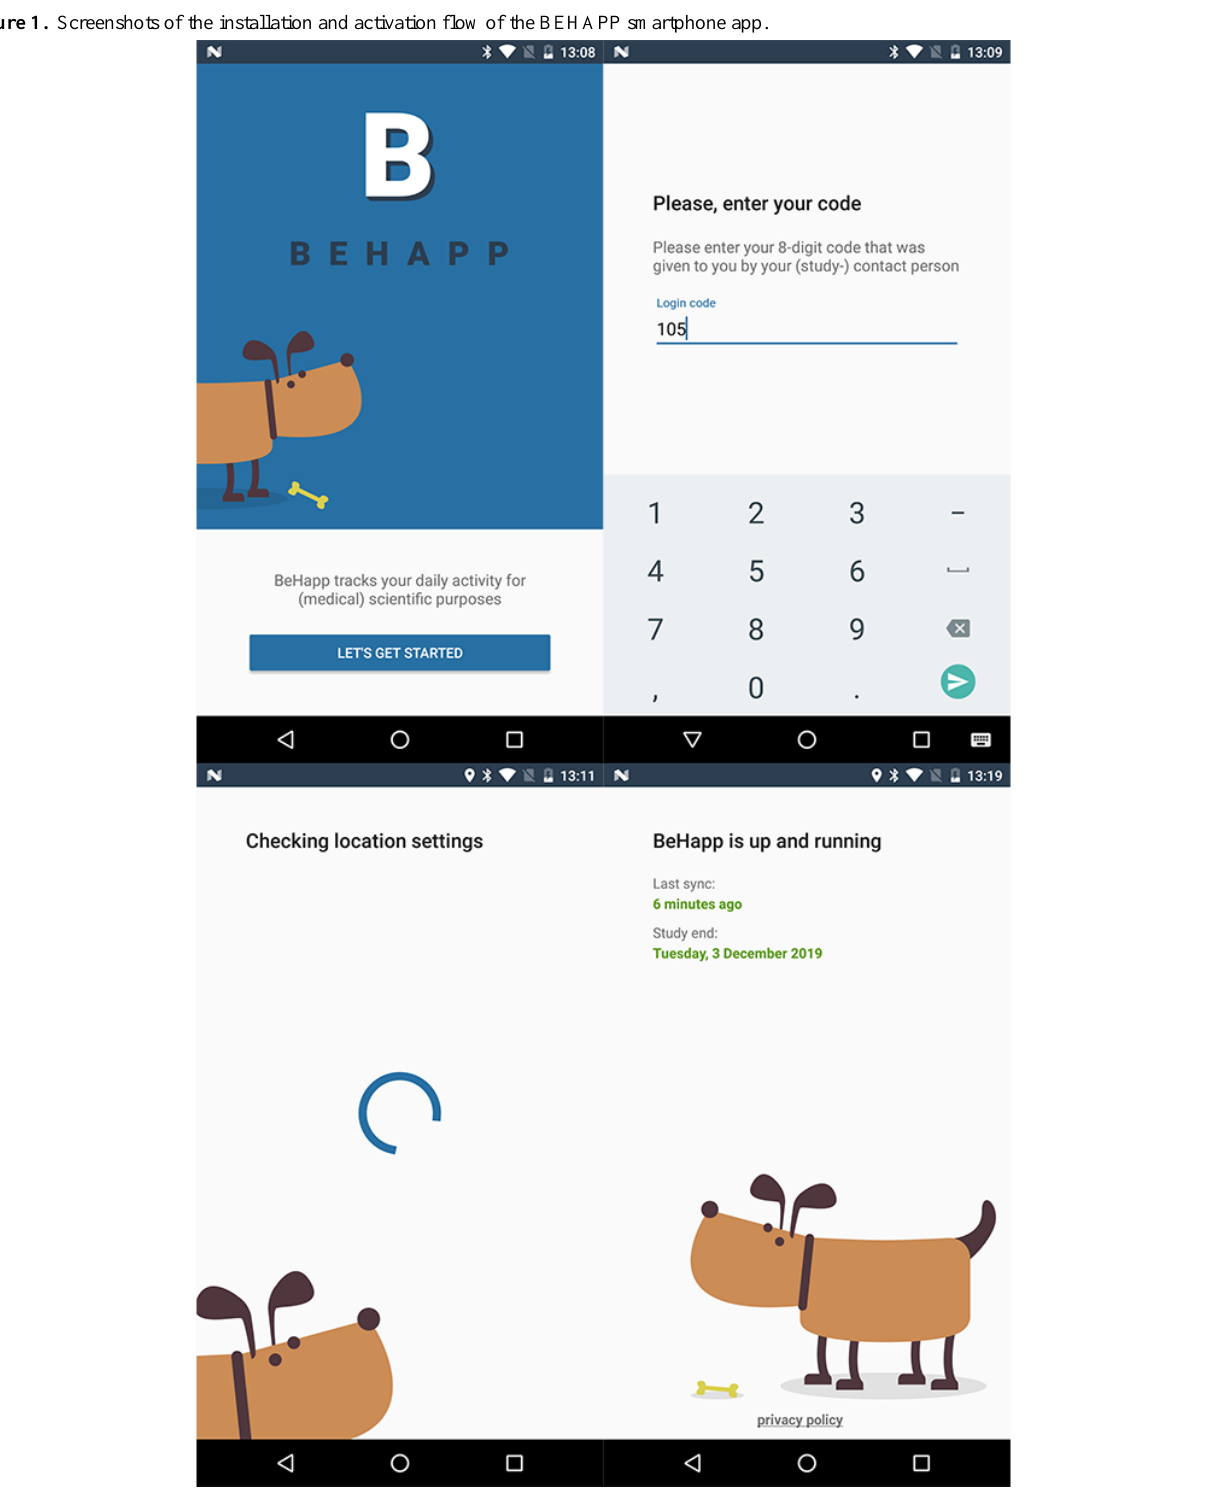
Figure 1. Screenshots of the installation and activation flow of the BEHAPP smartphone